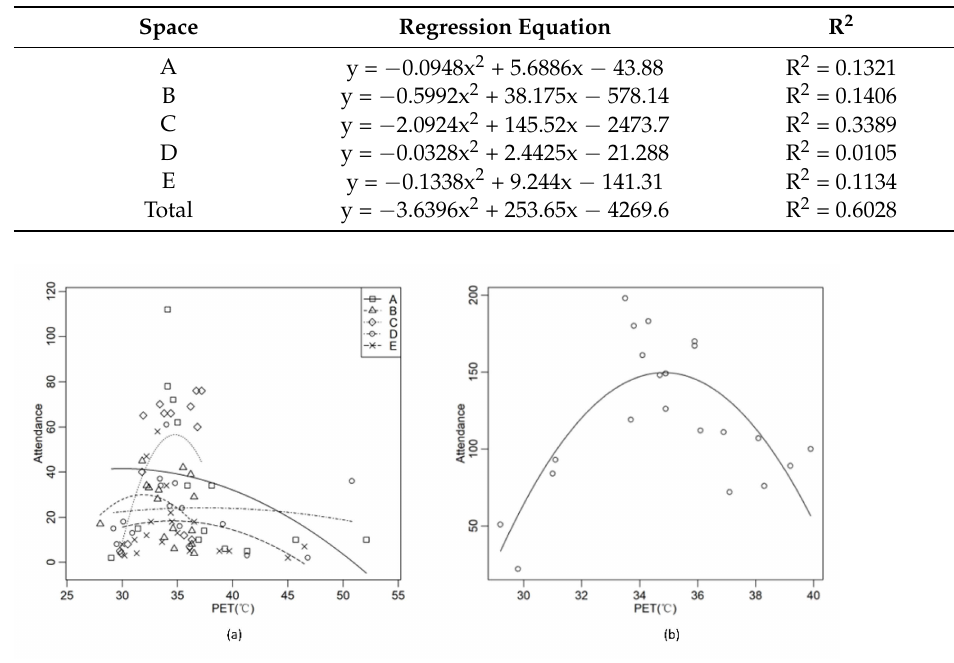
Figure 12. Relationship between attendance and PET. (The relationship between the respective attendance and PET for each of the five spaces ( a ), The relationship between total attendance and PET ( b